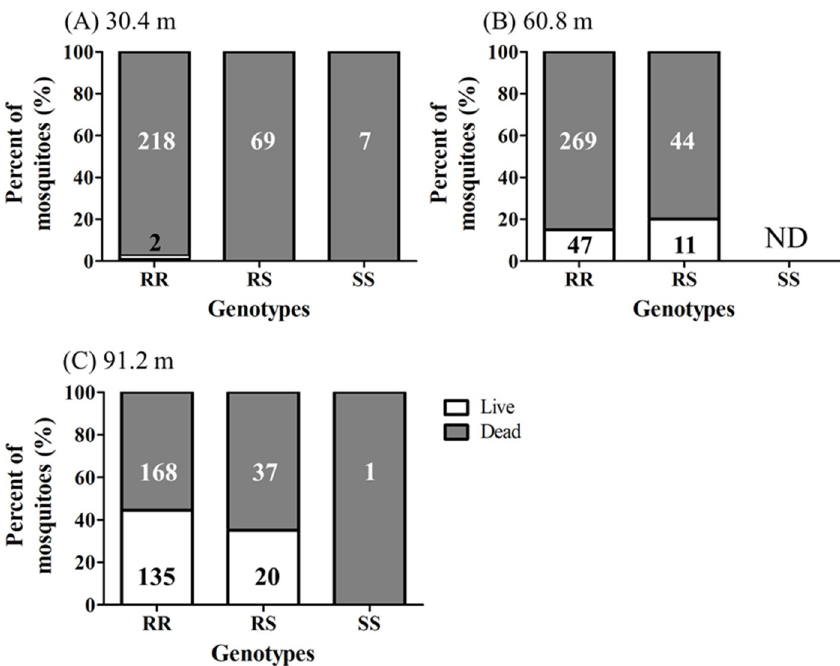
Fig 10. Percent of live or dead mosquitoes from the 6 areas by distances and genotypes. (A) 30.4 m from the point of Permanone 1 31–66 application. There were two homozygous resistant females that survived. (B) 60.8 m from the point of Permanone 1 31–66 application. (C) 91.2 m from the point of Permanone 1 31–66 application. ND = non- detected among field-collected mosquitoes. In white, over the gray zone in each bar, is the number of genotyped dead mosquitoes, and in black over the white zone, the number of genotyped mosquitoes that survived. At each of the three distances, there were no significant differences in the percent of dead mosquitoes depending on their RR or RS genotype (Chi-square tests). While the figure shows the number of susceptible mosquitoes these were not included in the analyses. In addition, results were confirmed by both the Breslow-Day test that found no evidence of a difference in the 11 odds-ratios ( P = 0.3283) (See text for explanation), and the CMH test allowed to conclude that there were not differences in the odds of death for RR and RS resistant